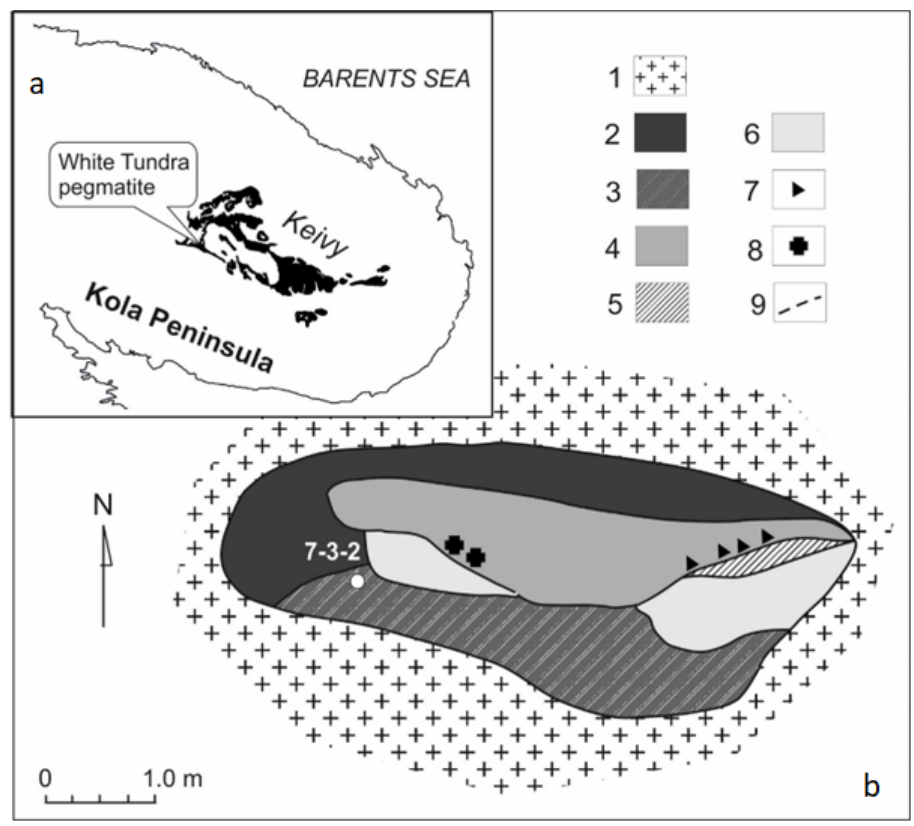
Figure 1. ( a ) Location of the White Tundra pegmatite in the Keivy alkaline province, Kola Peninsula. ( b ) Zones based on mineral assemblages in the pegmatite, 1—arfvedsonite-aegirine granite; 2—pegmatitic granite; 3—pegmatite, enriched in astrophyllite; 4—pegmatite, enriched in zircon, galena, and astrophyllite; 5—zone of secondary Y-REE mineralization; 6—quartz zone; 7—parts of maximum (up to 30 vol%) zircon content; 8—schlieren of galena; 9—zone boundaries. Modified after Lyalina et al.